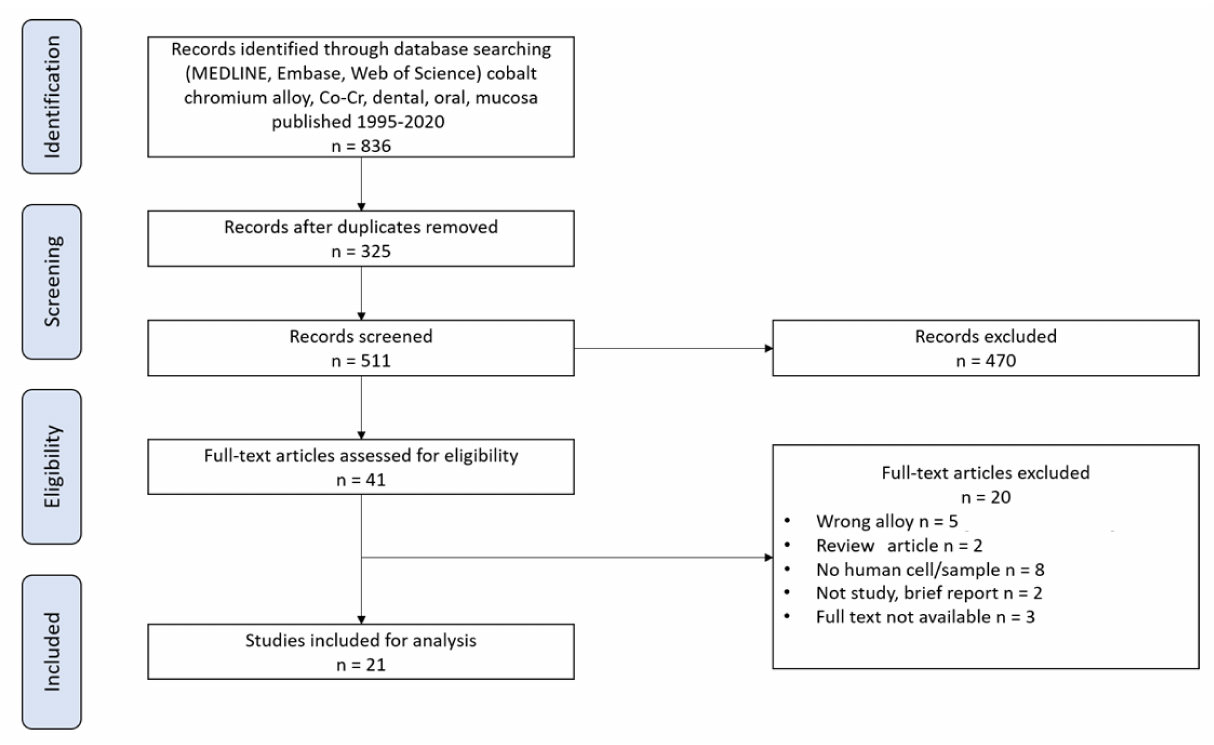
Figure 1. Flow diagram of study selection. Table 1. Main characteristics of articles extracted from Medline , Embase , and Web of Science